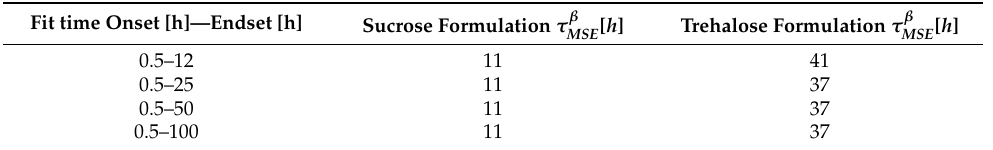
Table 2. Comparison of the calculated τ β were chosen between 12 h and 100